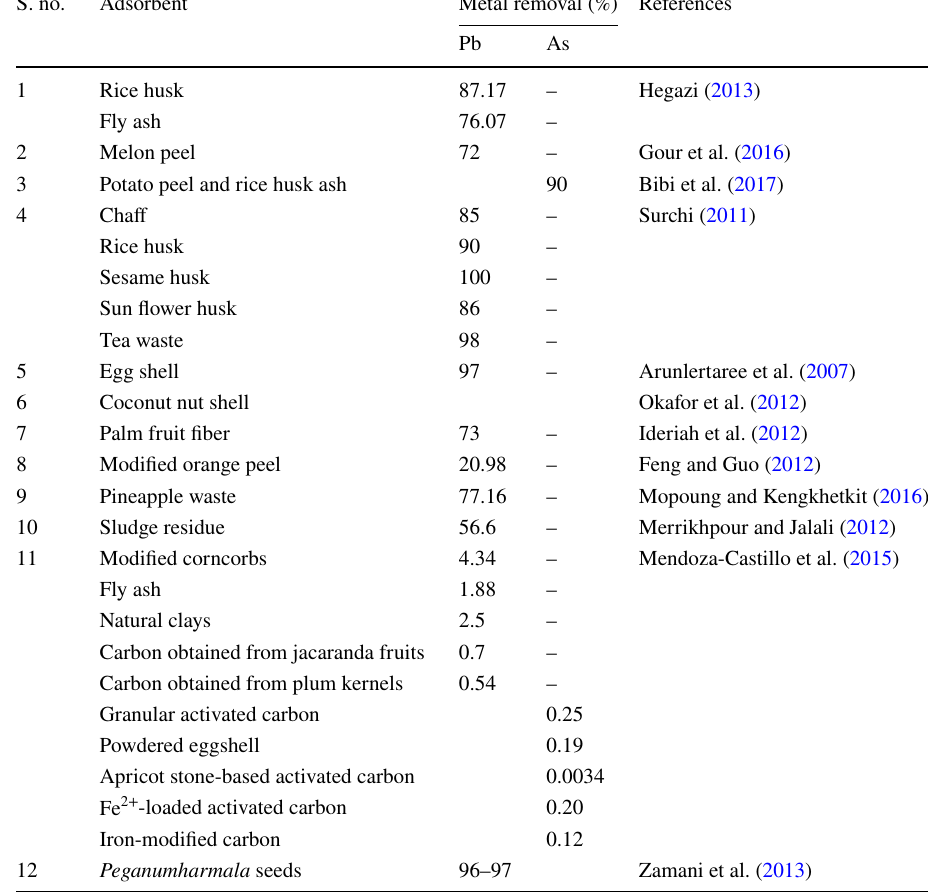
Table 3 Summary of low-cost adsorbent from forest and agriculture